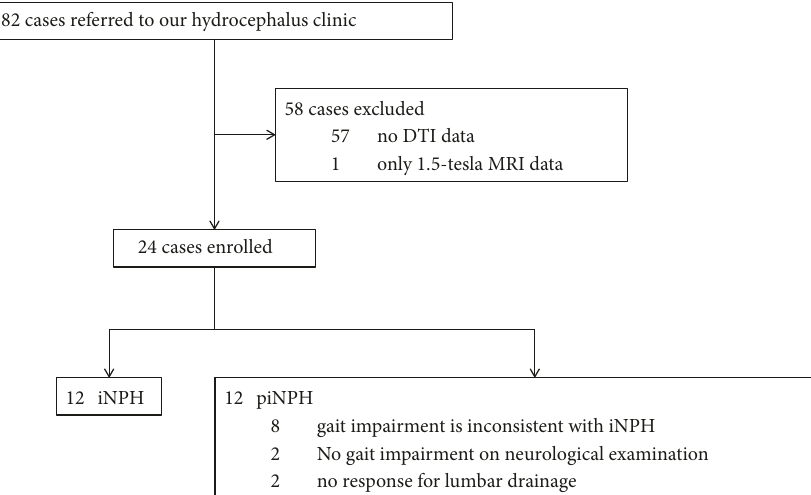
Figure 1: Flow chart of patient